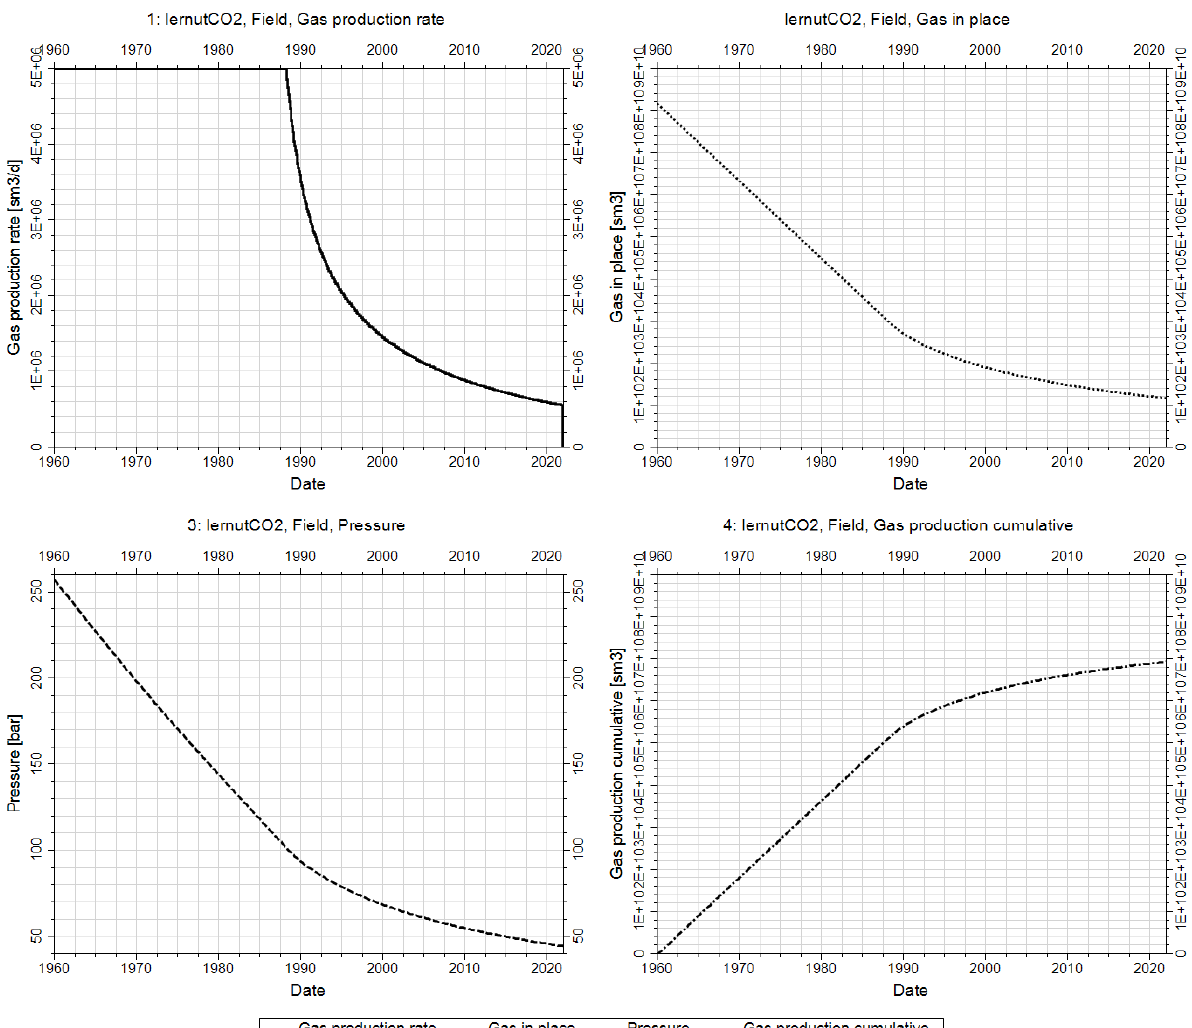
Figure 6. Depletion stage of the reservoir through 21 wells between 1960 and